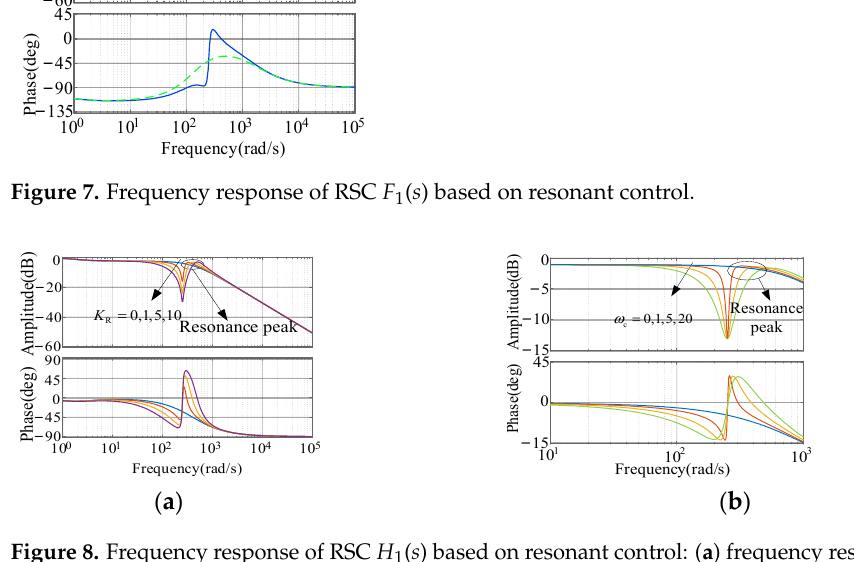
Figure 8. Frequency response of RSC H 1 ( s ) based on resonant control: ( a ) frequency response of H 1 ( s ) when K R changes; ( b ) frequency response of H 1 ( s ) when ω c changes.